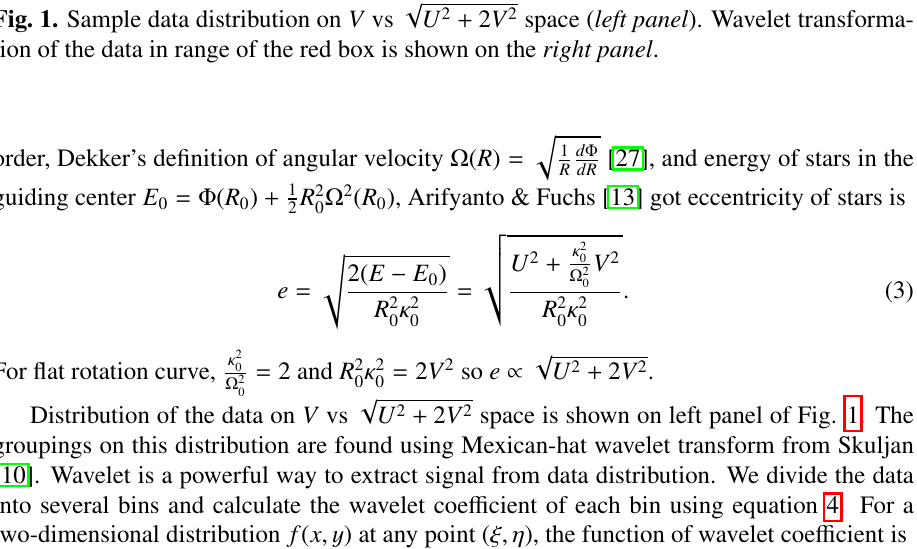
√ U 2 + 2 V 2 space ( left panel ). Wavelet transforma-